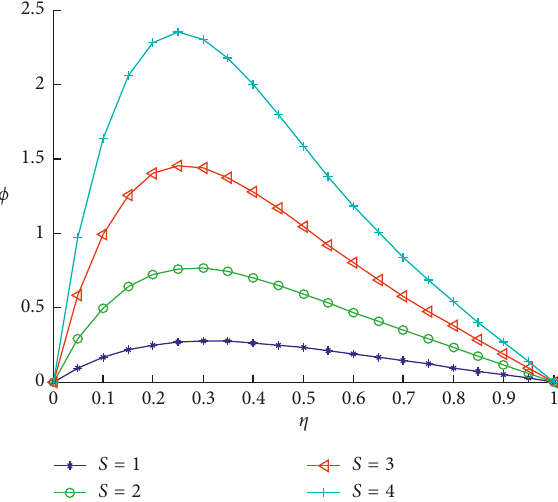
Figure 16: Effect of the thermophoresis parameter on the con- centration profile when A M Pr 0 . 5 , Le 1 . 0 , and C (cid:31) (cid:31) (cid:31)